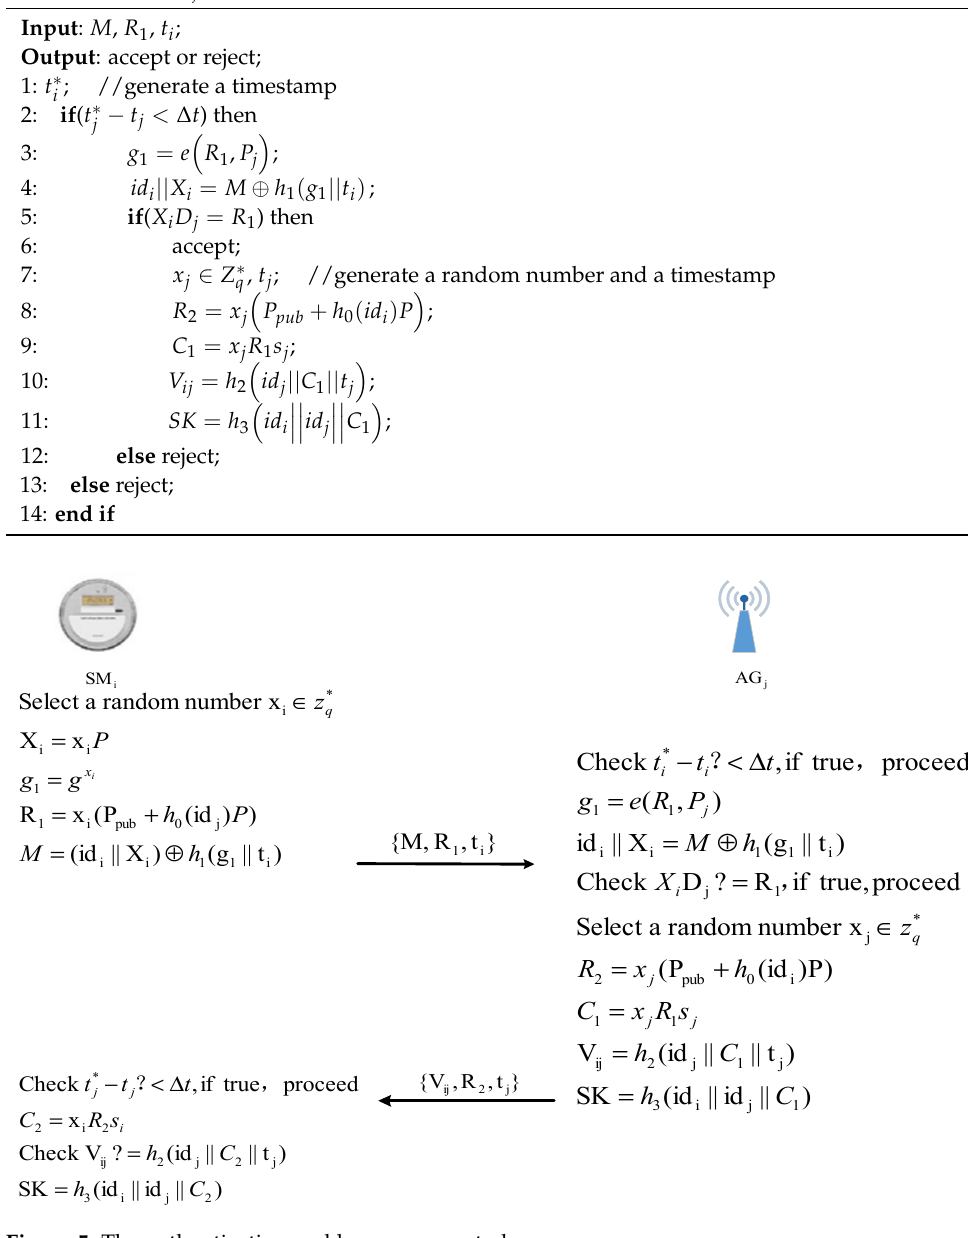
Figure 5. The authentication and key agreement phase.